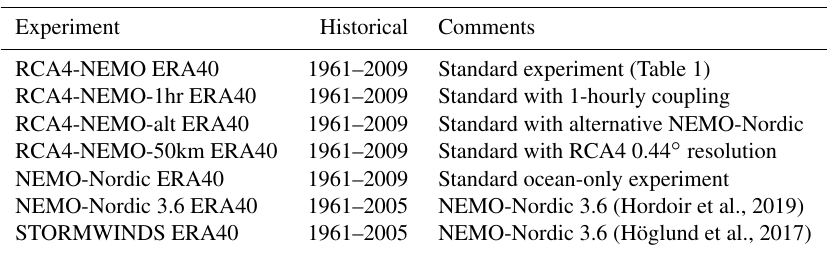
Table 2. Sensitivity experiments with different RCMs forced with ERA-40. RCA4-NEMO-1hr ERA40 is the same setup as RCA4-NEMO ERA40 but the atmosphere and ice–ocean components are coupled every hour. RCA4-NEMO-alt is another coupled setup, where the ocean component is replaced by an alternative NEMO-Nordic setup. RCA4-NEMO-50km is a setup where the RCA4 is run at a resolution of 0.44 ◦ . NEMO-Nordic indicates the ocean component used in the regular RCA4-NEMO setup. Here, it is used as an ocean-only setup that has been forced with the output of RCA4 ERA40. NEMO-Nordic 3.6 ERA40 is the ocean-only setup validated by Hordoir et al. (2019). STORMWINDS ERA40 is an ocean-only setup for the Baltic Sea that has been used in the STORMWINDS project (Höglund et al., 2017).